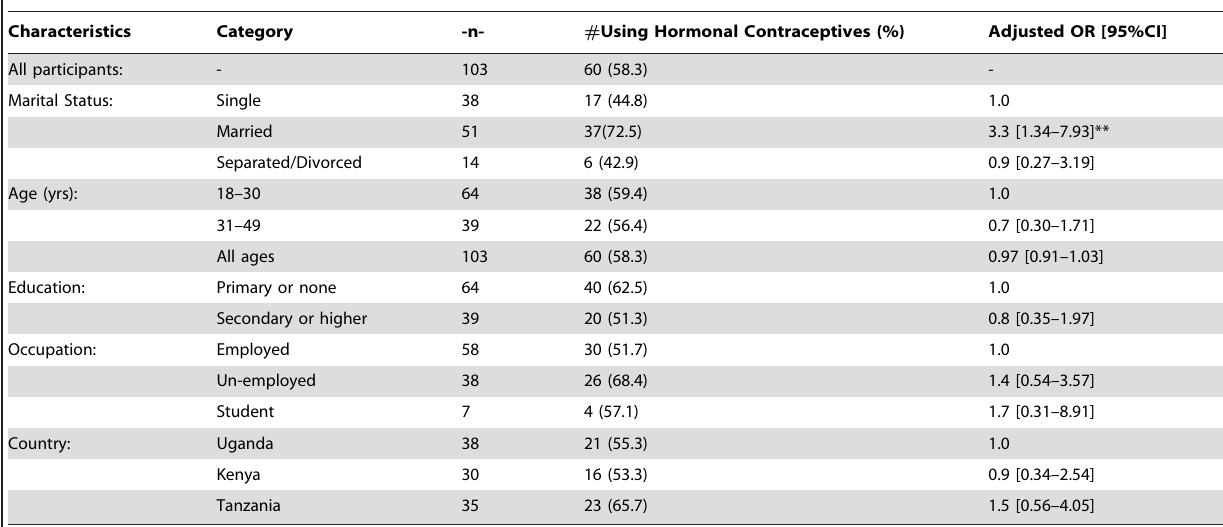
Table 4. Use of Hormonal Contraceptives by Participant Characteristics*